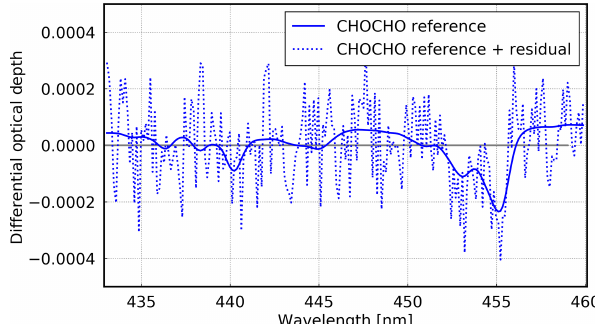
Figure 6. Example of a CHOCHO fit for 13 October 2016 at 11:33UTC (latitude: ∼ 10.8 ◦ N; longitude: ∼ 20.0 ◦ W). The SCD is 6.17 × 10 14 moleccm − 2 with a rms of 1.3 × 10 − 4 at 29.75 ◦ SZA and a viewing angle of 7 ◦